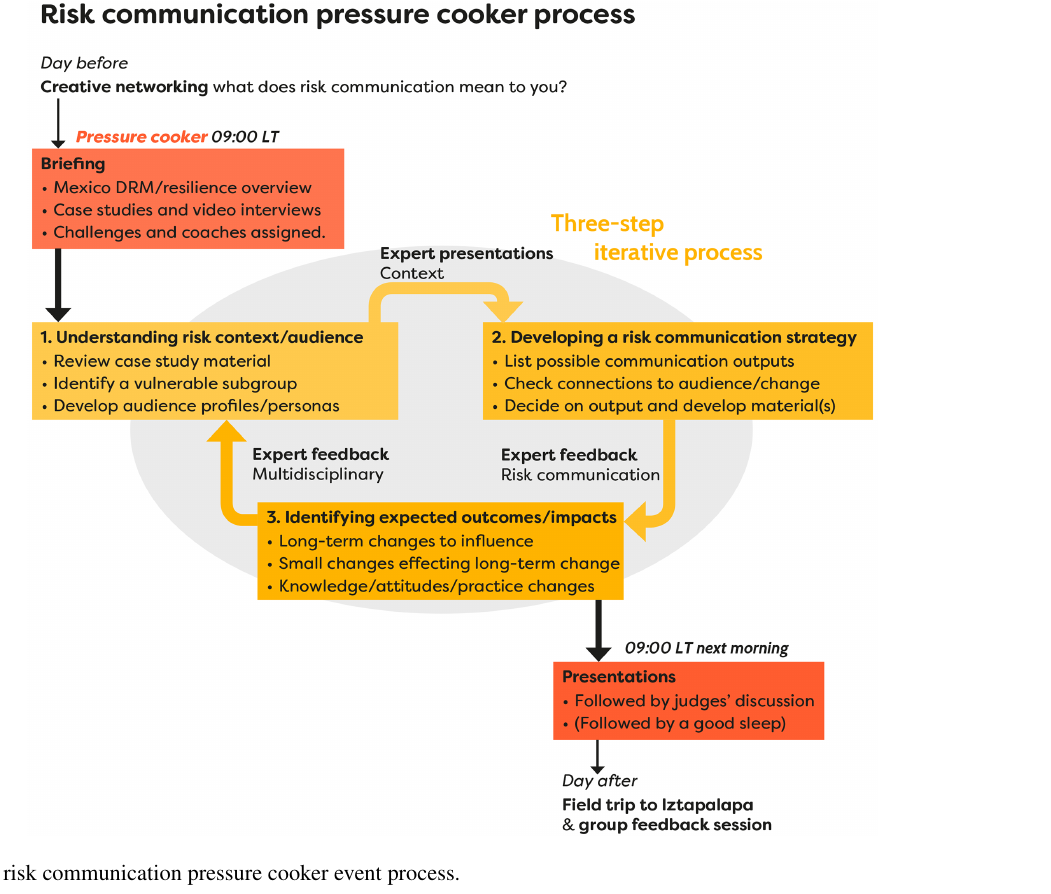
Figure 2. The 24h risk communication pressure cooker event process.